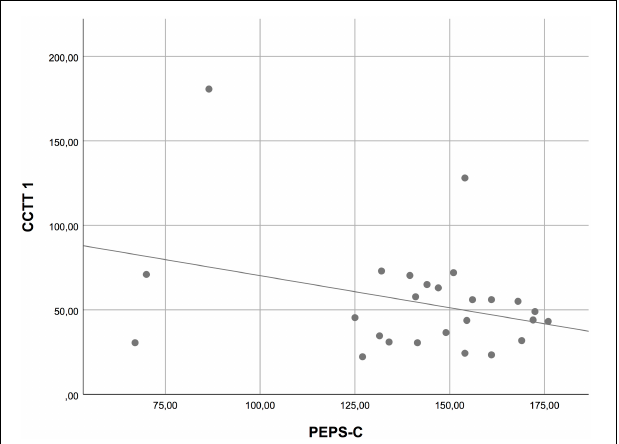
TABLE 2 | Scores in PEPS-C tasks and CCTT components in the high-functioning autism (HFA) and typically developing (TD) groups. TD Group HFA Group Mean ( SD